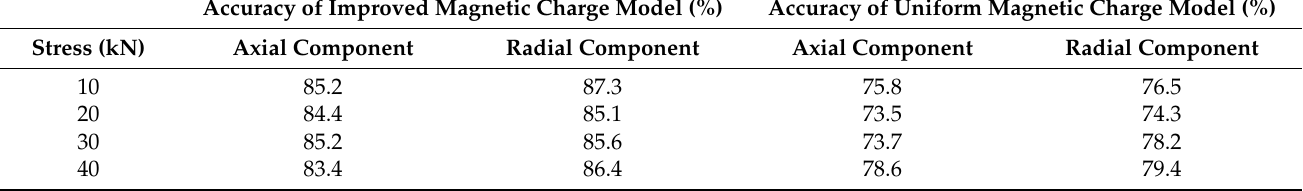
Table 2. Precision analysis of the improved magnetic charge model and uniform magnetic charge